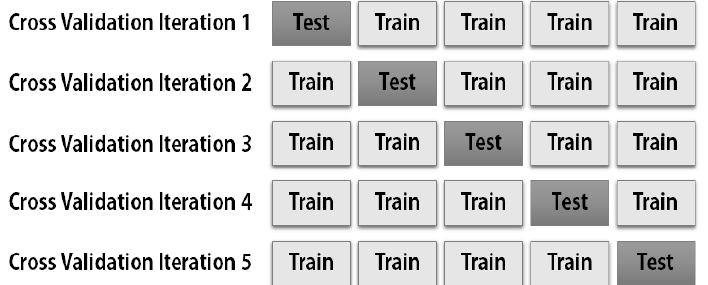
Figure 8. Concept of K-fold cross-validation.